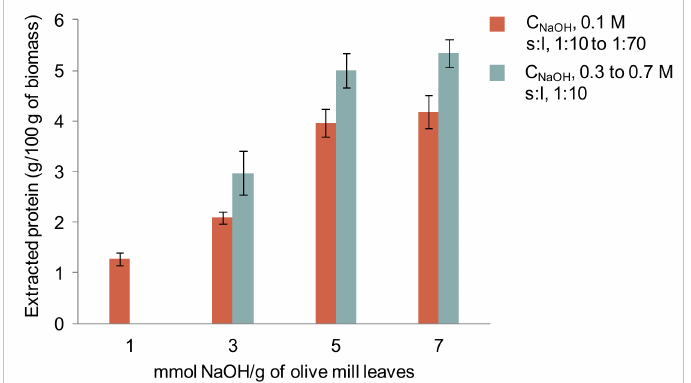
Figure 4. Amount of protein extracted using di ff erent ratio of alkali to solid, which was obtained using di ff erent NaOH concentration (C NaOH ) and solid-to-liquid ratio (s:l)